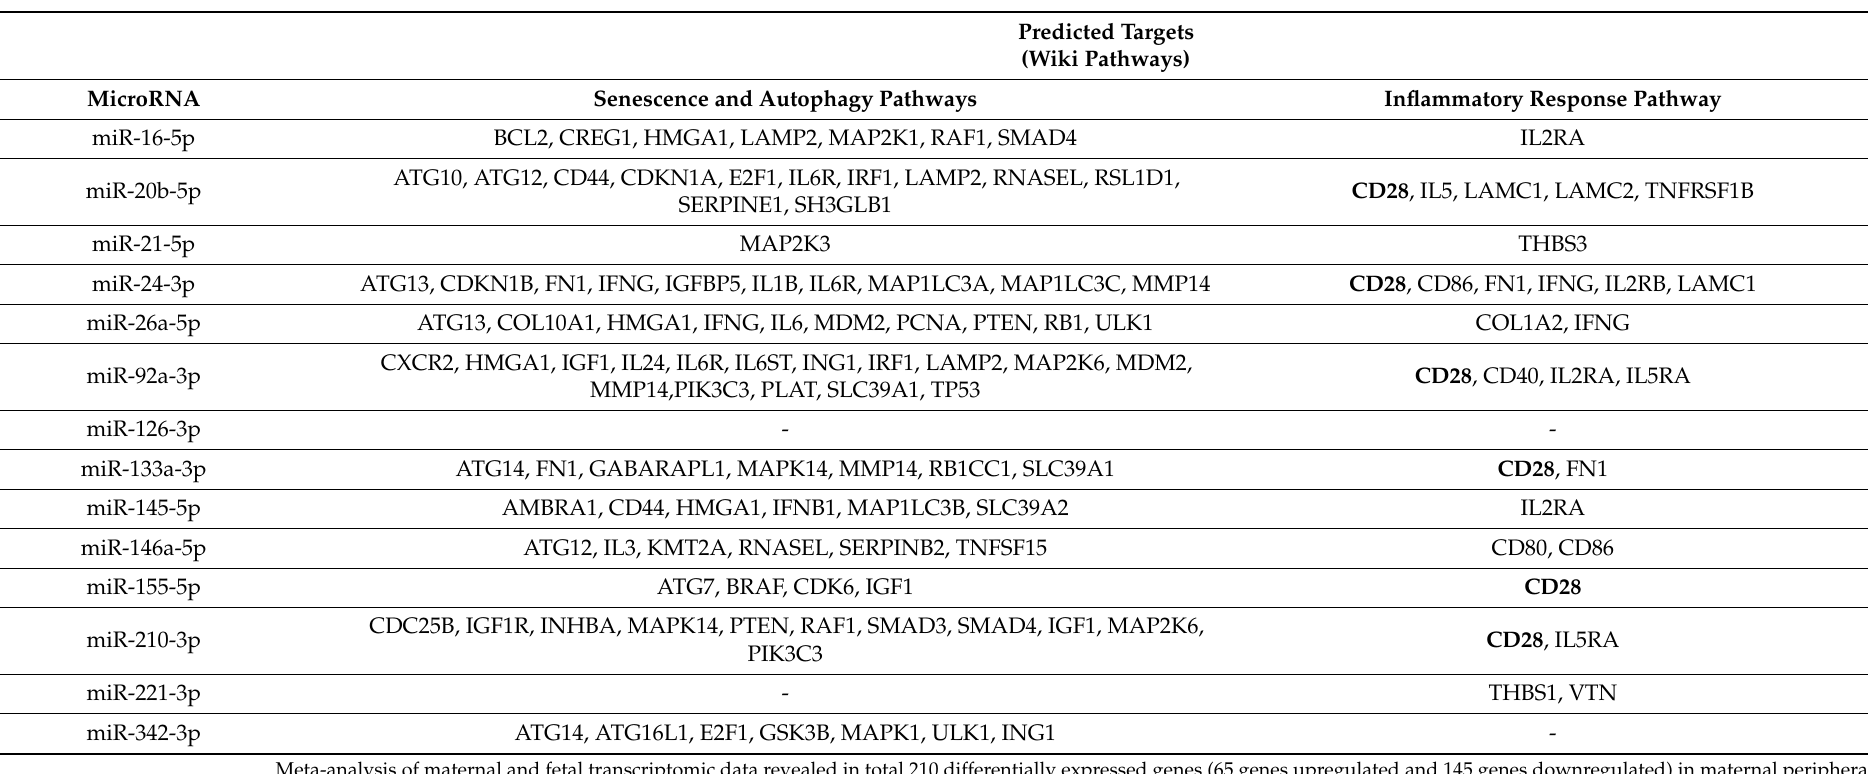
Table 3. A List of Predicted Targets of MicroRNAs Dysregulated in the Whole Peripheral Blood of Pregnancies at Risk of Preterm Delivery in relation to the Senescence and Autophagy Pathways and the Inflammatory Response Pathway, using the miRWalk2.0 Database (Data Available in WIKI